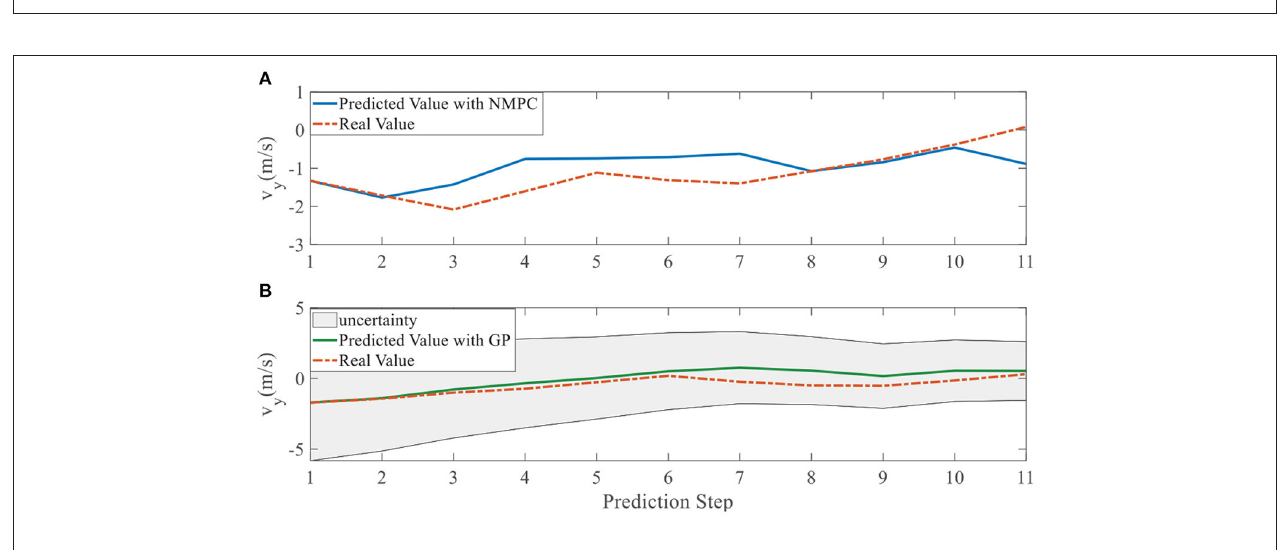
FIGURE 17 | Velocity v y evolution in right overtaking. (A) NMPC; (B) GPMPC.